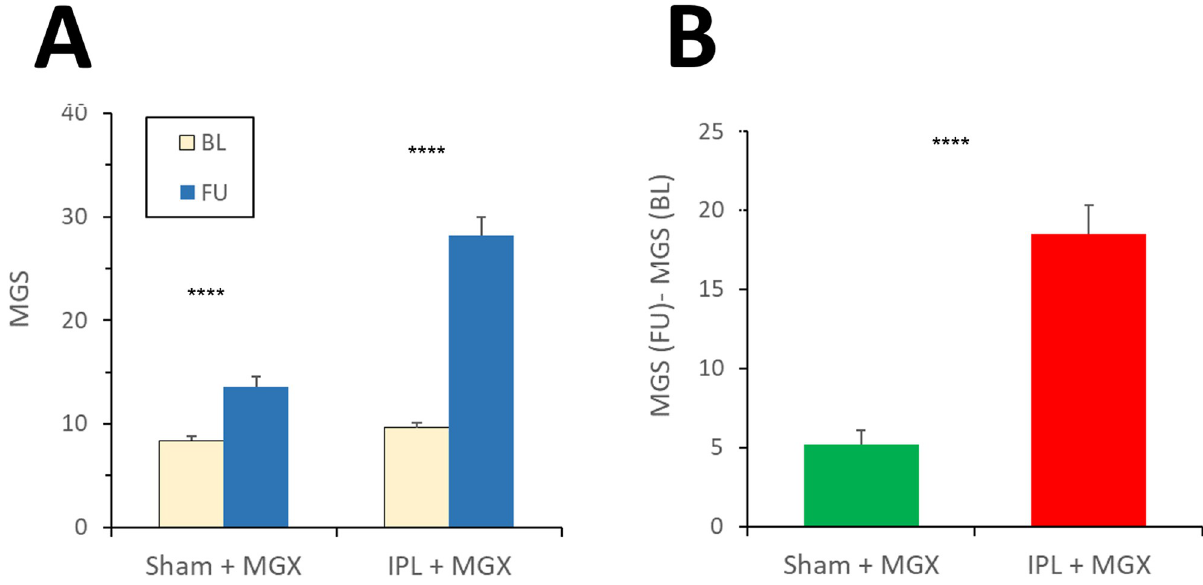
Fig 4. Change of MGS. A . Absolute values of MGS at BL and FU; ���� : p (within arms) < 0.0001. B . Change of MGS from BL to FU ( Δ MGS); ���� : P (between arms) < 0.0001.